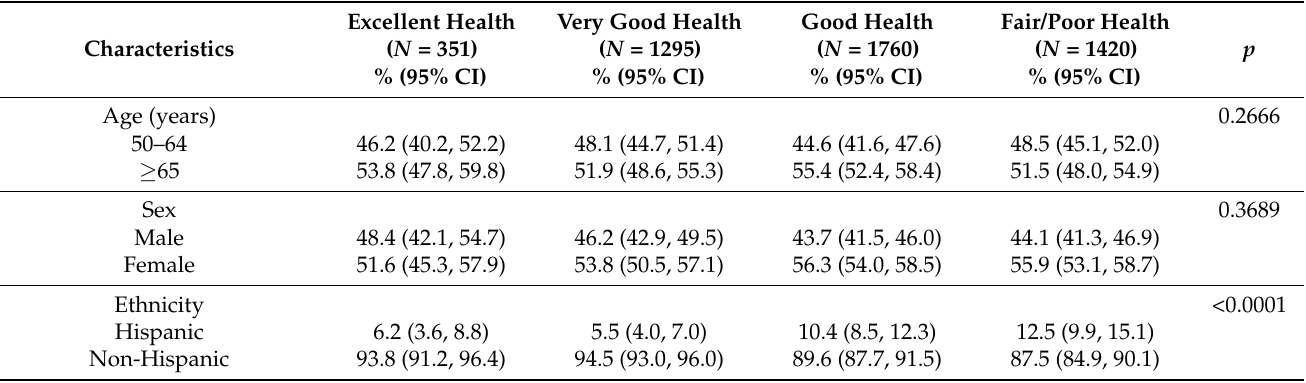
Table 2. Sample characteristics of older United States adults with self-reported pain in the past four weeks, stratified by self-reported perceived health